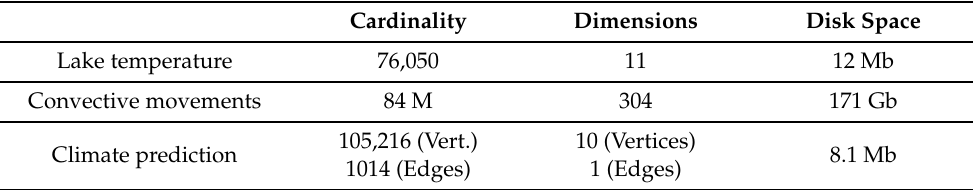
Table 1. Dataset and characterization of the use cases under